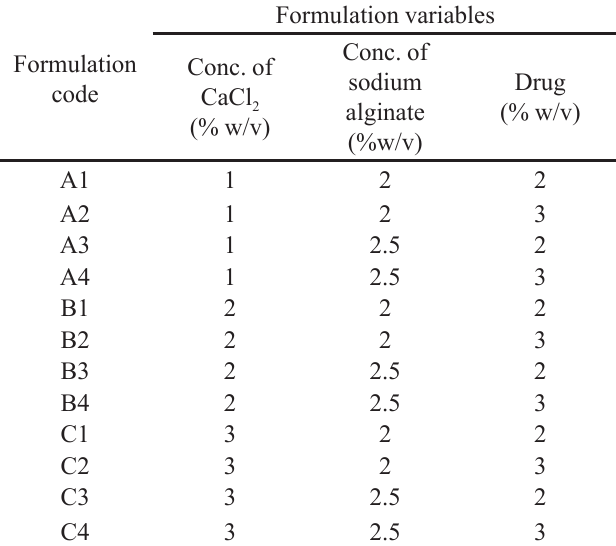
TABLE I - Composition of TMZ-loaded calcium alginate beads